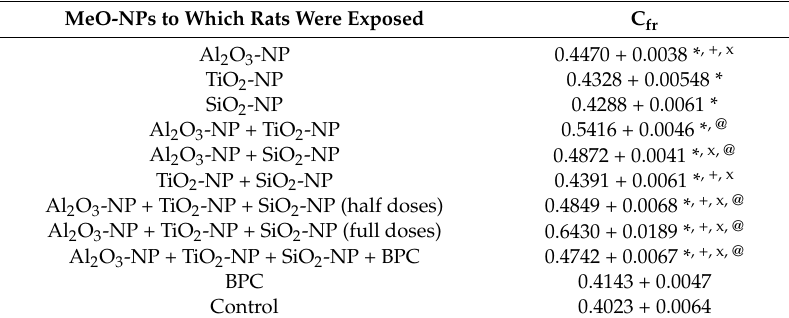
Table 12. Increase in the Coefficient of Genomic DNA Fragmentation (C fr ) (as per RAPD Test) of Nucleated Blood Cells in Rats after 18 (during 6 Weeks) Repeated Intraperitoneal Injections of Suspensions of Various MeO-NPs Individually and in Binary or Ternary Combination (x ± s.e.). MeO-NPs to Which Rats Were Exposed C fr Al 2 O 3 -NP 0.4470 + 0.0038 * , +, x TiO 2